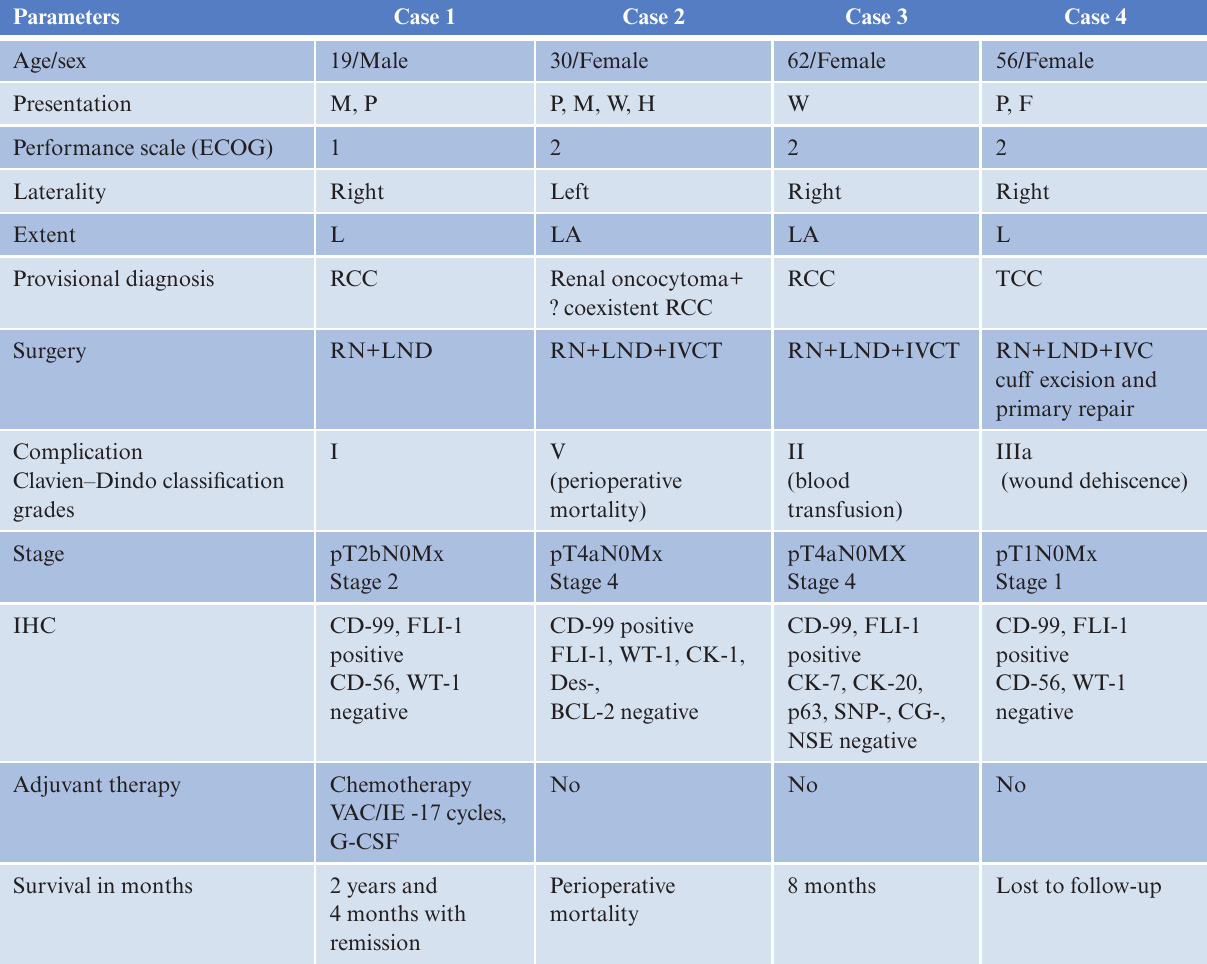
Table 1: Summary of clinical presentation, and treatment and follow-up of four cases of renal PNET.